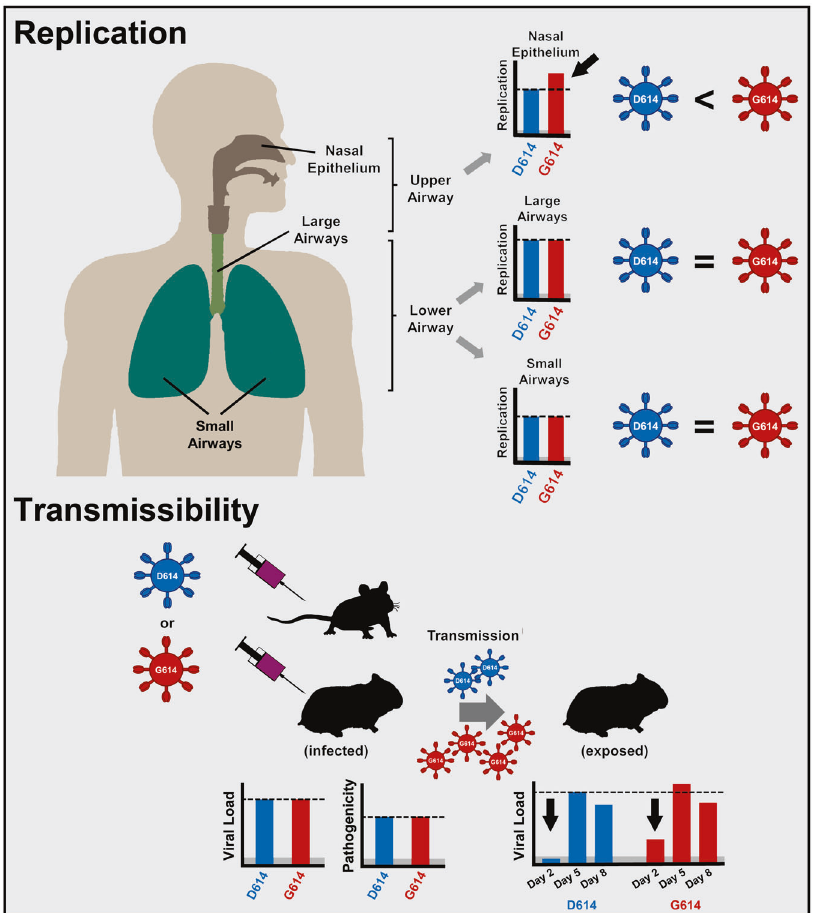
Fig. 1 Mutation D614G in the SARS-CoV-2 spike protein augments transmission. Viruses with the amino acid substitution D614G show increased replication capacity in the human nasal epithelium but not small and large airways ex vivo. Replication of G614 virus in the nasal epithelium